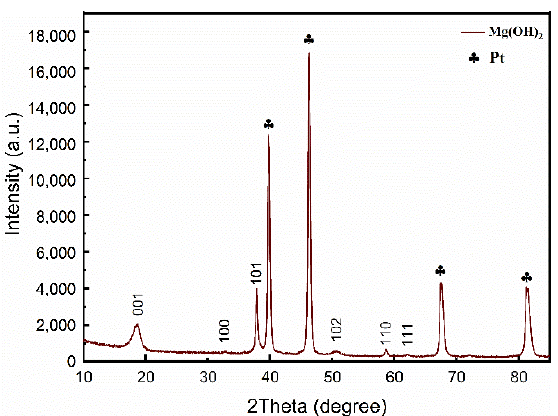
Figure 5. Powder X-ray diffraction patterns of as-prepared Mg(OH) 2 on electrode